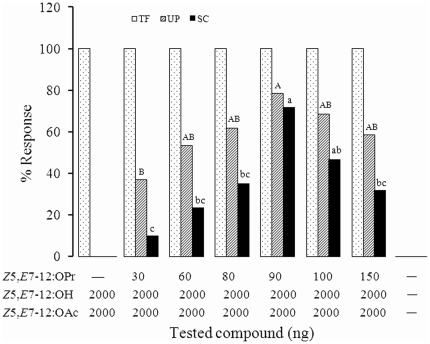
Percentages of males exhibiting three key behaviors in the flight tunnel in response to various doses of Z5,E7-12:OPr blended with fixed amounts of Z5,E7-12:OAc and Z5,E7-12:OH (doses in ng).Taking flight = TF, (light bars); upwind flight over a 1.2-m distance = UP, (hatched bars with different upper-case letters were significantly different by Tukey's test at p = 0.05 following ANOVA, F
5,12 = 4.30, p = 0.018); and source contact = SC, (dark bars with different lower-case letters were significantly different by Tukey's test at p = 0.05 following ANOVA, F
5,12 = 13.47, p<0.001).